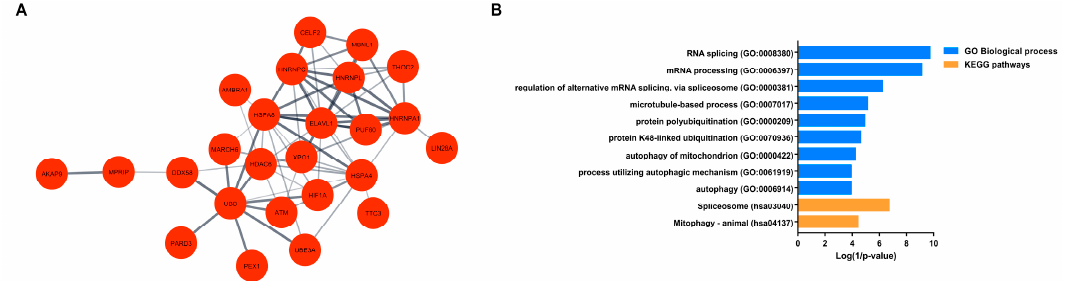
Figure 3. Enrichment and network analyses of up-regulated DEGs. ( A ) Protein–protein interaction (PPI) network of selected most up-regulated genes (nodes). The interactions (edges) line thickness indicates the strength of data support. ( B ) Enrichment analysis of the interacting up-regulated genes in the PPI network. Biological processes (blue) and KEGG pathways (orange) are plotted on the y -axis versus their Log (1/ p -values) on the x -axis.